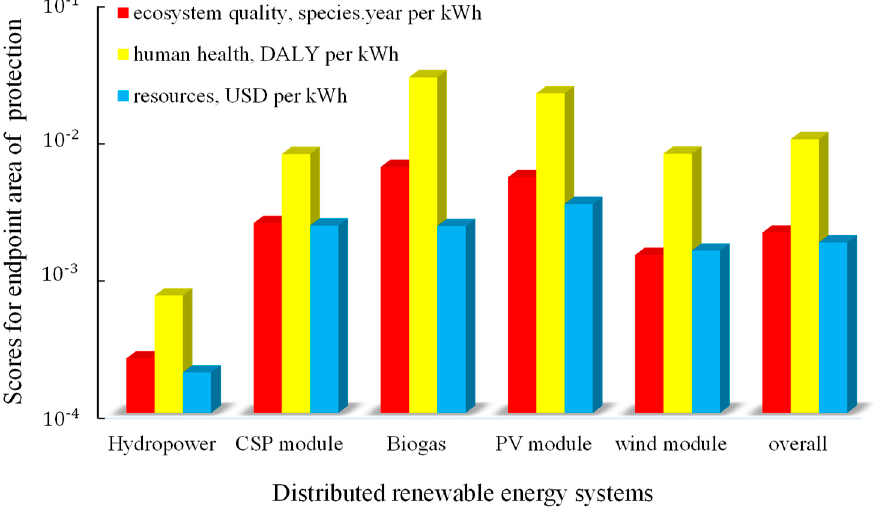
Figure 4. Environmental impact scores per product for endpoint area of protection of each power generation technology and overall distributed energy system.